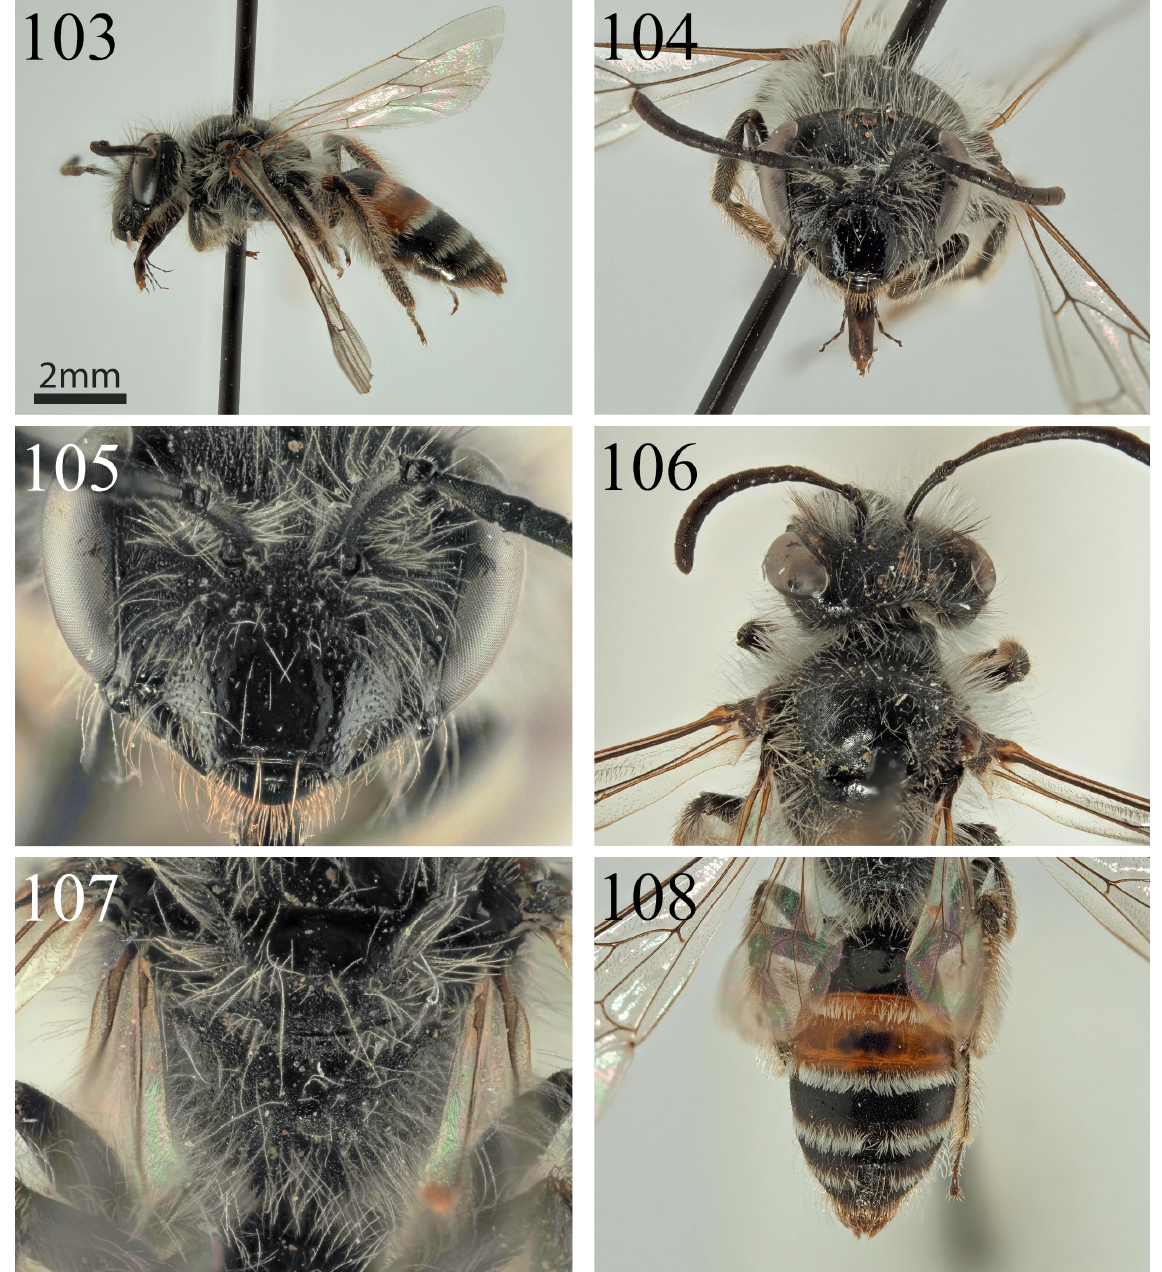
Figs 103–108. Andrena sella Wood sp. nov., ♀ (OÖLM). 103 . Profile. 104 . Face. 105 . Face, detail. 106 . Dorsum. 107 . Propodeum. 108